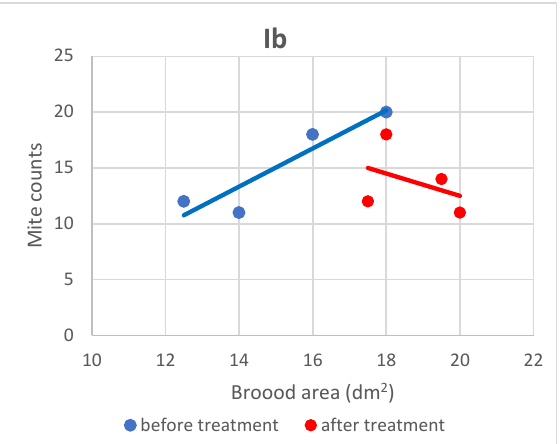
Figure 4. Linear regression plots of brood area (fixed factor) and mite counts in subgroup IIA before and after treatment.